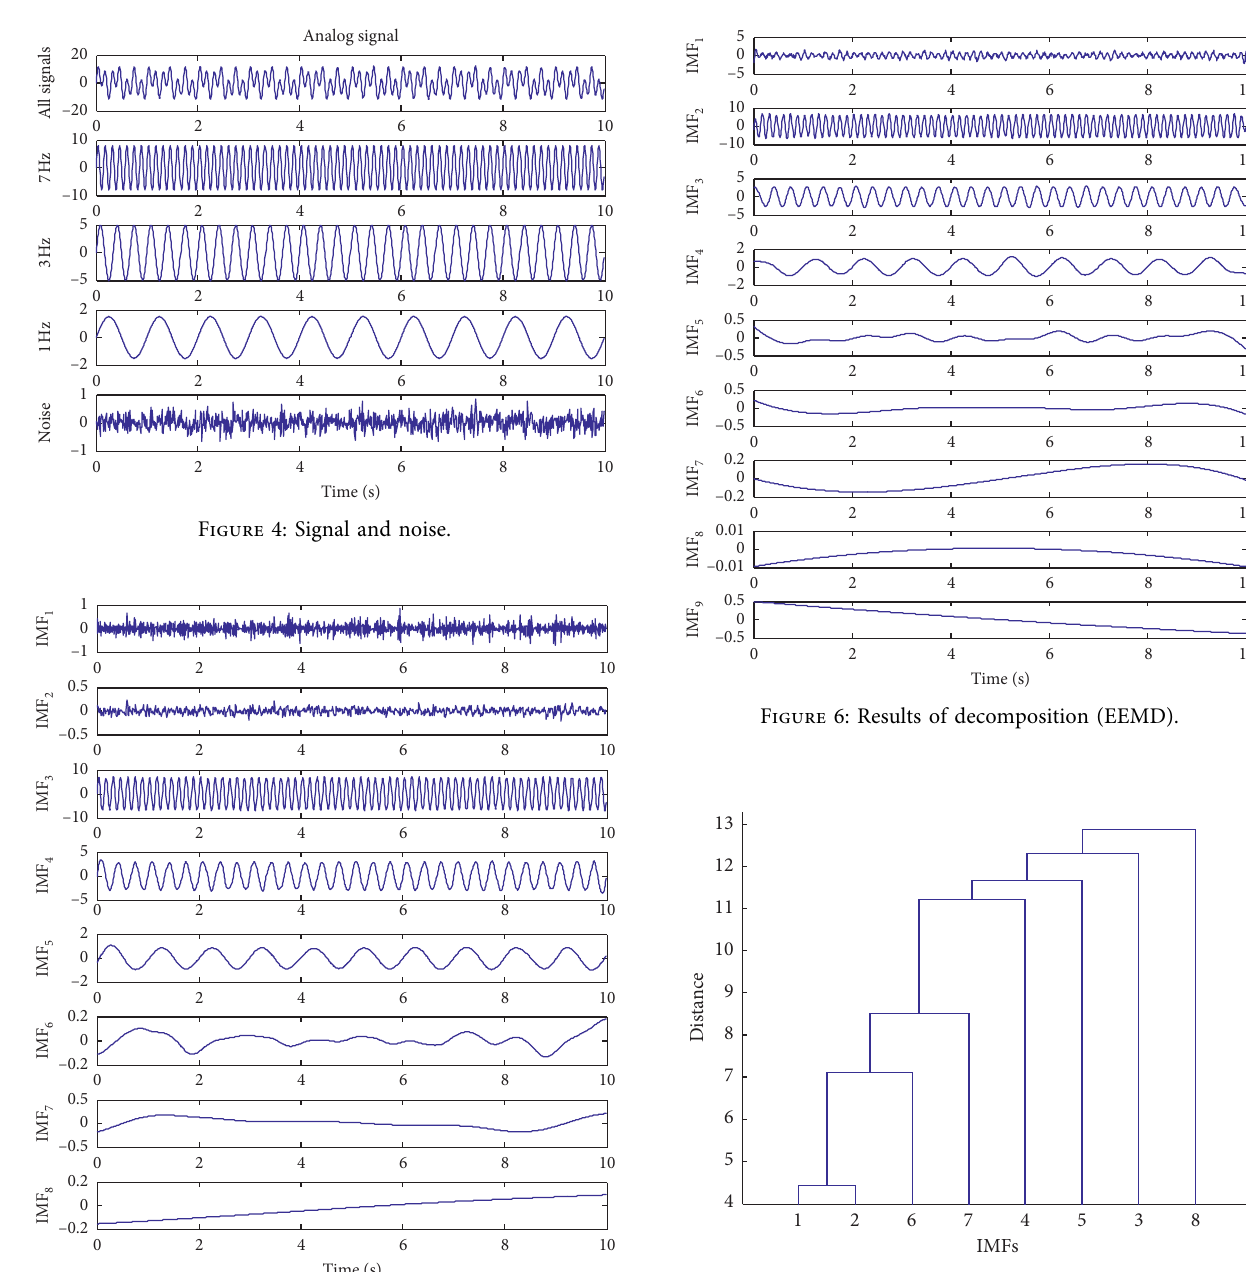
Figure 7: Results of clustering (improved EEMD).